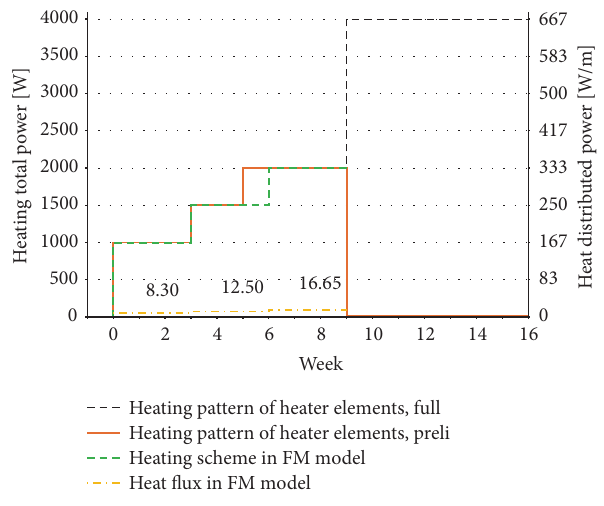
Figure 6: The heating power plan per heater